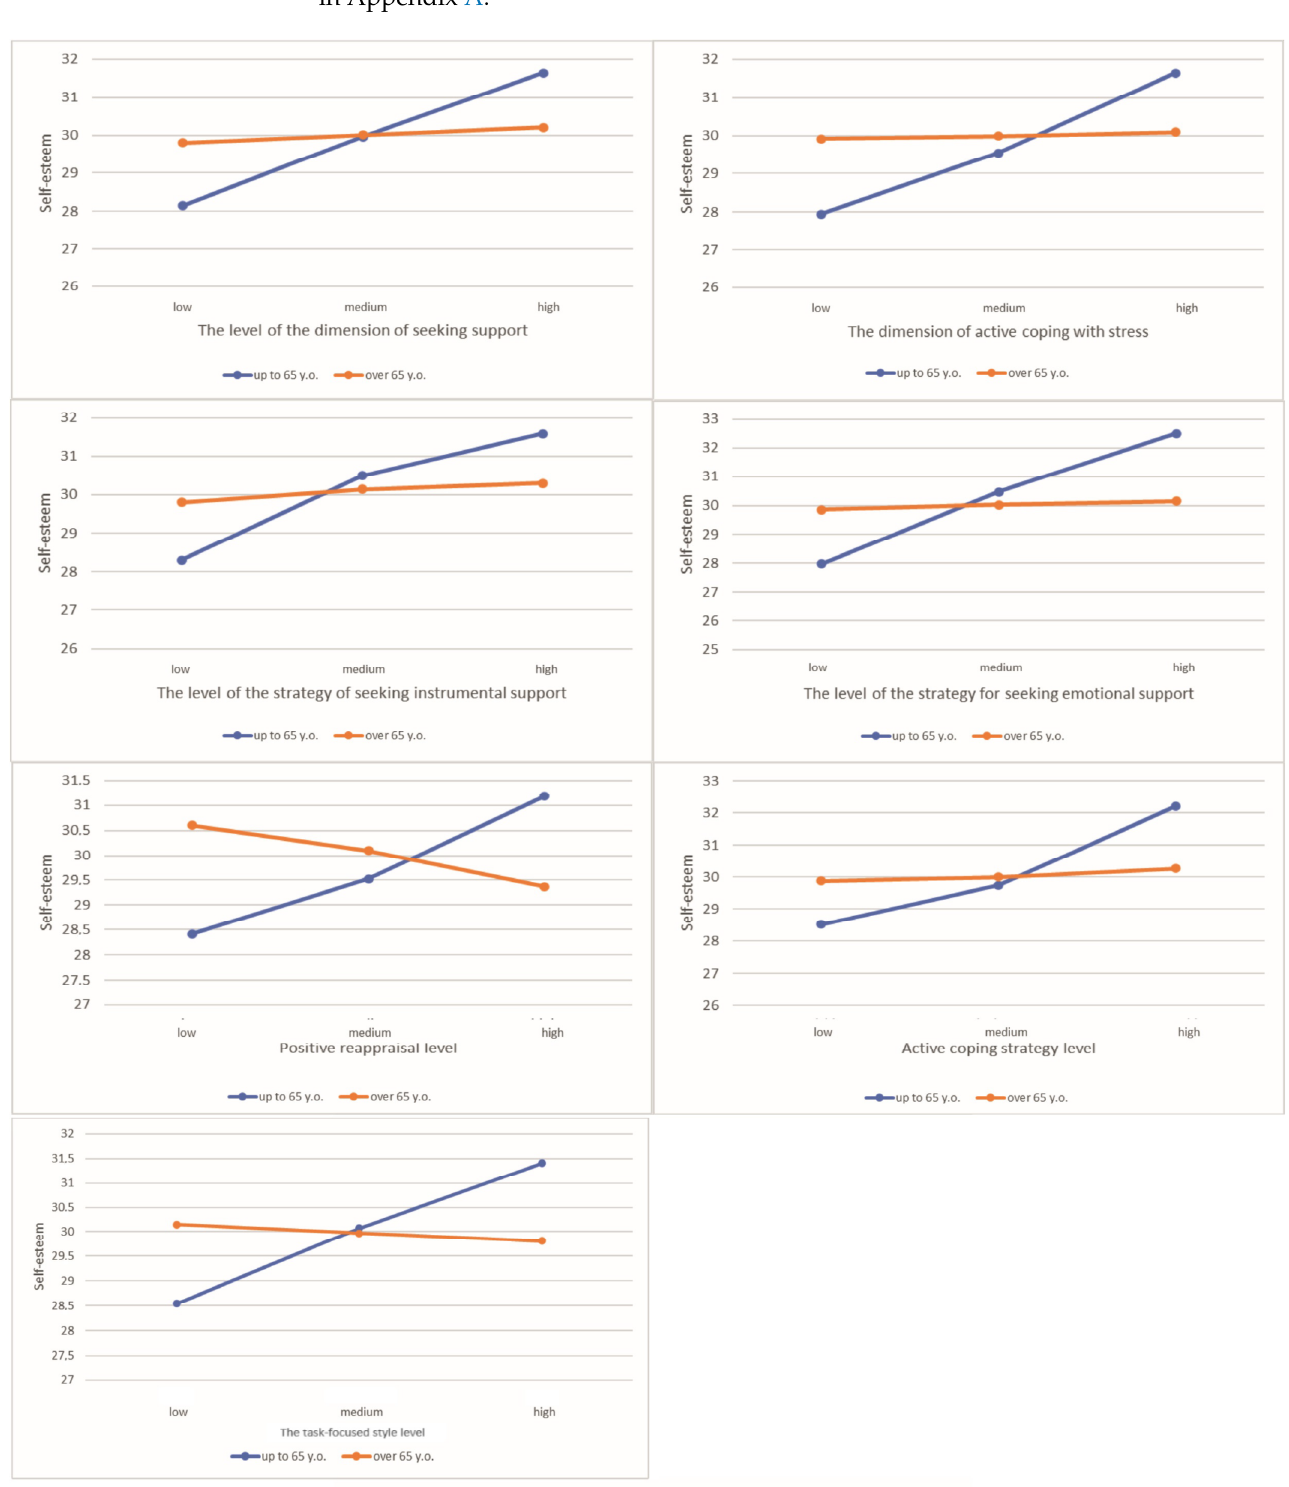
Figure 1. Associations between the strategy of coping and patients’ self-esteem.